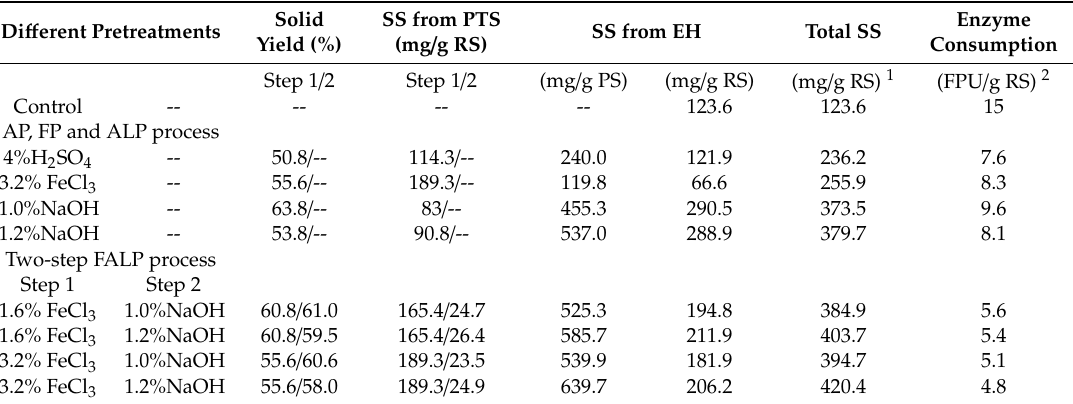
Table 2. Mass balance of the whole